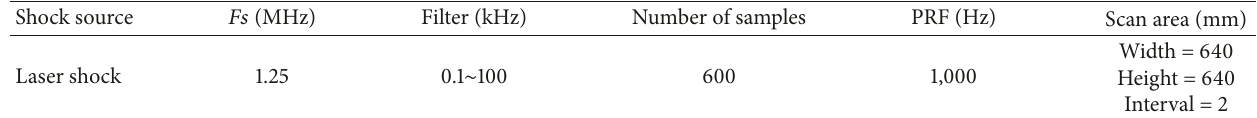
Table 1: Laser shock measurement condition for reconstruction of linear explosive induced